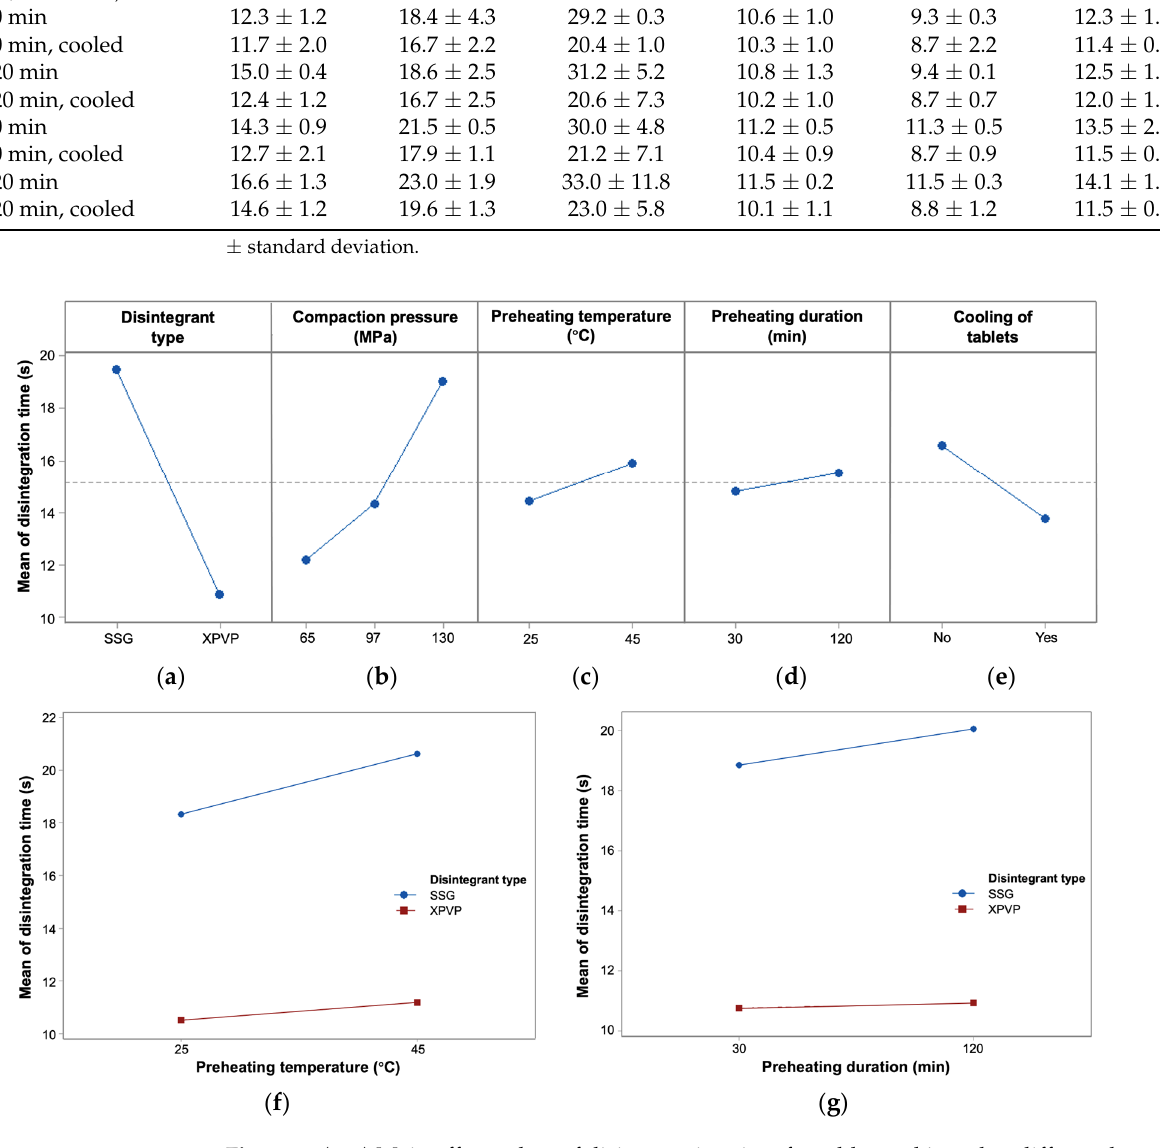
Figure 8. ( a – e ) Main effects plots of disintegration time for tablets subjected to different heat treat- ments; interaction plots of ( f ) preheating temperature and disintegrant type, and ( g ) preheating duration and disintegrant type. Note: The dotted line indicates the average disintegration time of the tablets in this study.